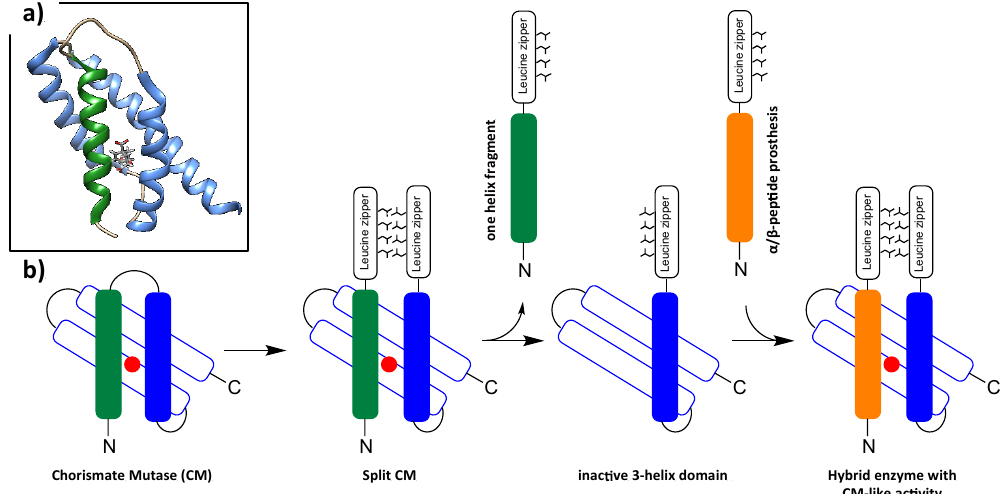
Figure 9. ( a ) Ribbon diagrams of the monomeric chorismate mutase (PDB code 2gtv) [128]. ( b ) Schematic representation of chorismate mutase (CM) and its split variant. Exchange of the one helix fragment (green) with a α / β -peptide surrogate (orange) led to a hybrid enzyme with CM-like activity. The active site is symbolized by a red circle [121] .